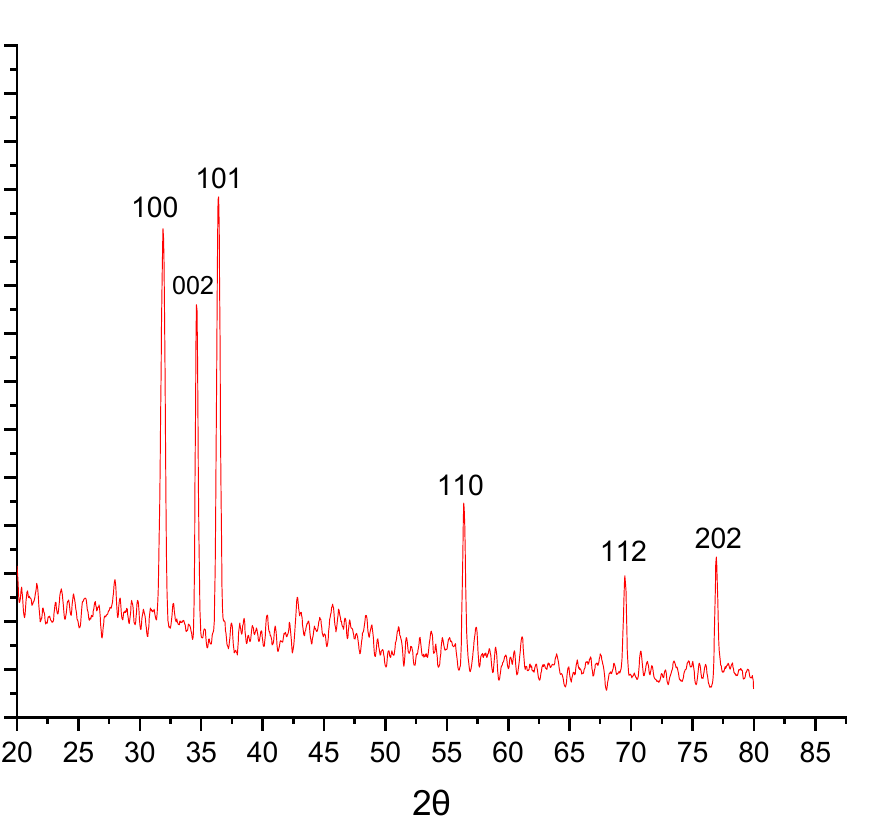
Figure 8. XRD analysis of zinc oxide nanoparticles synthesized using aqueous pomegranate peel extract.